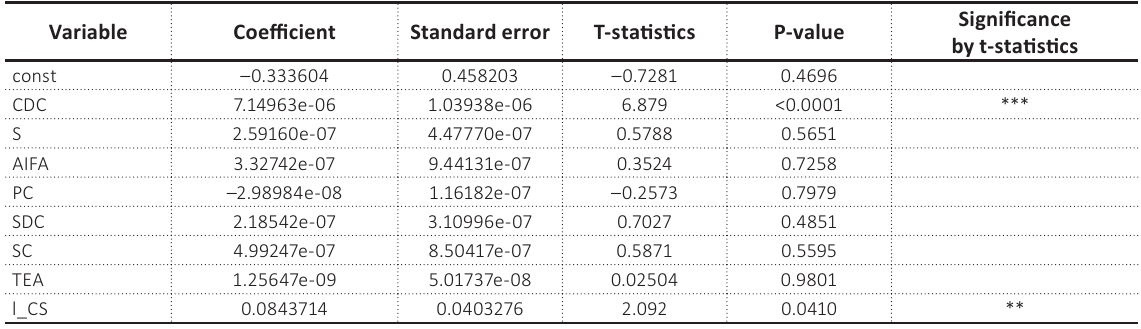
Table 9. Model 4 (EBITM). FEM (robust standard errors), using the observations 1-80